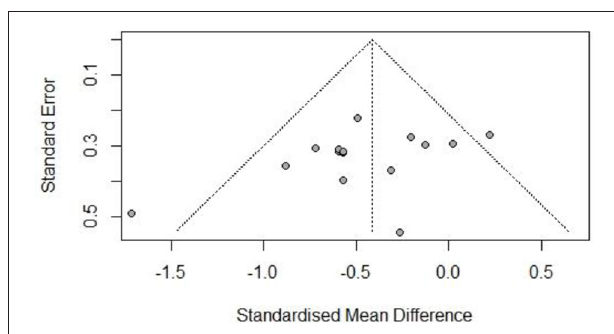
FIGURE 4 | Funnel plot of body fat (BF).